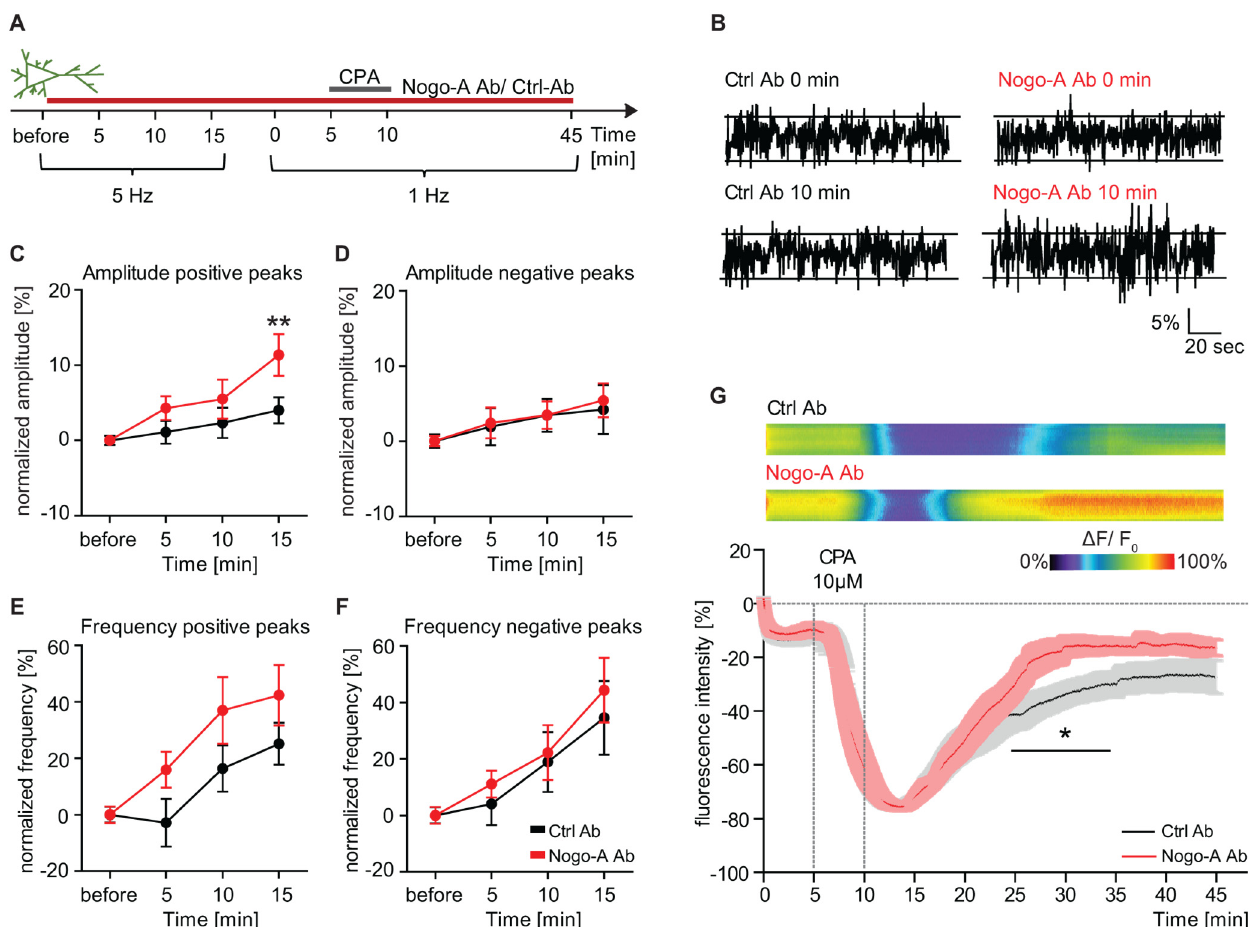
Figure 4. Ca 2+ influx versus intracellular Ca 2+ release upon Nogo-A loss-of-function. ( A ) Time scheme of live-cell imaging of a transfected neuron with the genetically encoded ER-targeted Ca 2+ sensor ER-GCaMP6-150 in hippocampal primary cell culture. After baseline recording, the neuron was recorded at 5 Hz after control or Nogo-A antibody application for 15 min. As second part of the experimental setup, the same neuron was recorded at 1 Hz for 45 min and the additional treatment with Cyclopiazonic acid (CPA; 10 µM) for a total of 5 min. ( B ) Example traces for changes in relative fluorescence intensity of ER-mediated Ca 2+ transients before and after 10 min treatment with the control (black) or the function-blocking antibody Nogo-A (red). The background noise is delineated by the dashed lines and serves as a threshold for the peaks that exceed the defined range and are counted for their frequency and measured amplitude of Ca 2+ transients. Scale bar Δ F/F0 5% vertical and 20 sec horizontal. ( C – F ) Normalized values for frequency and amplitude of ER-mediated Ca 2+ transients upon control antibody (black, n = 10) or Nogo-A function-blocking antibody (red, n = 10) over time. Percentage change in ( C ) amplitude of positive directed peaks, ( D ) amplitude of negative directed peaks, ( E ) frequency of positive directed peaks and ( F ) frequency of negative directed peaks. ( G ) Representative pseudo line-scans of ER-GCaMP6-150 transfected neuron representing changes in Ca 2+ fluorescence of control antibody or Nogo-A function-blocking antibody upon CPA wash-in and wash-out. Heat map for a range of 0–100% intensity change is displayed. Averaged percent change of fluorescence intensity tracked over a time course of 45 min upon treatment with either Ctrl (grey, n = 9) or Nogo-A function-blocking antibody (red, n = 9). All data are presented as mean ± SEM. * p < 0.05.